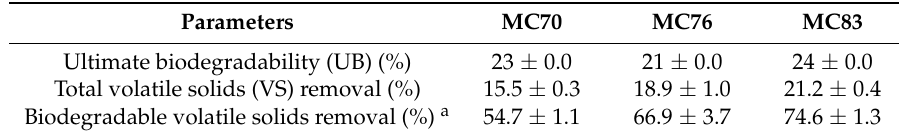
( BMR ) × Initial VS × UB ). Removed biomass ( BMR ) ). Initial VS × UB × 100 Removed biomass ( BMR ) Initial VS × UB × 100